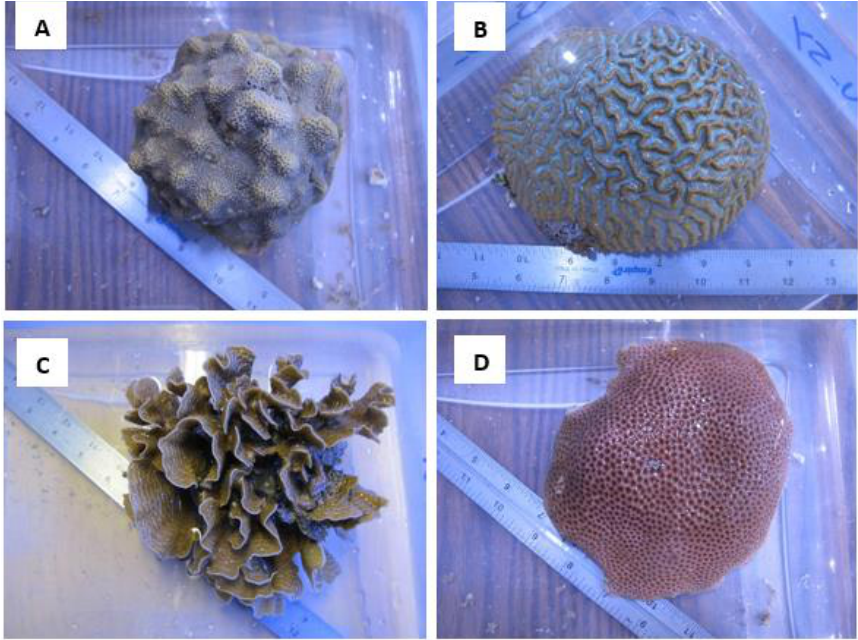
Figure 1. Sample photographs of the coral species cultured in the experiment of Bove et al. (2019) [38] and investigated here: ( A ) Porites astreoides , ( B ) Pseudodiploria strigosa , ( C ) Undaria tenuifolia , and ( D ) Siderastrea siderea .